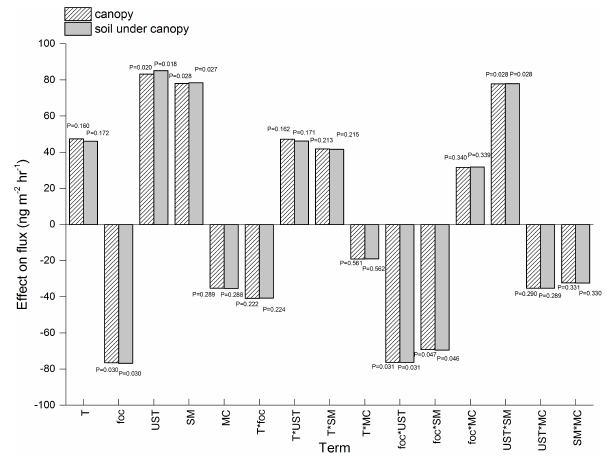
Figure 7. Sensitivity analysis based on the 2 5 factorial design at canopy level after pre-screening model variables shown in Table 4 to isolate the significant factors. The overall flux at canopy level is dominated by the soil flux under the canopy (the sensitivity of foliar exchange is shown in Figure 8). T denotes surface air temperature; foc denotes fraction of organic carbon in soil; UST denotes friction velocity; SM denotes soil Hg content; MC denotes soil moisture. "*" denotes interaction effects.